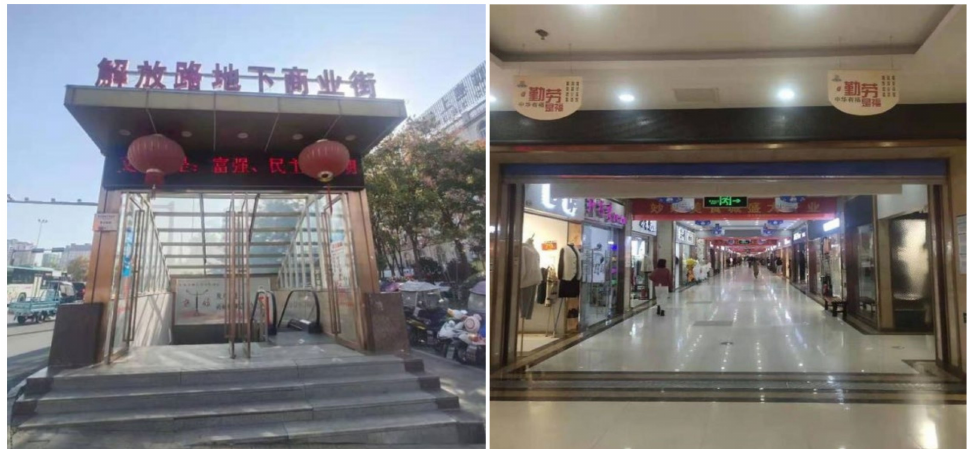
Figure 3. Layout of the underground commercial street and sound source survey in Jiefang Road, Lu’an (1–5: sampling points).